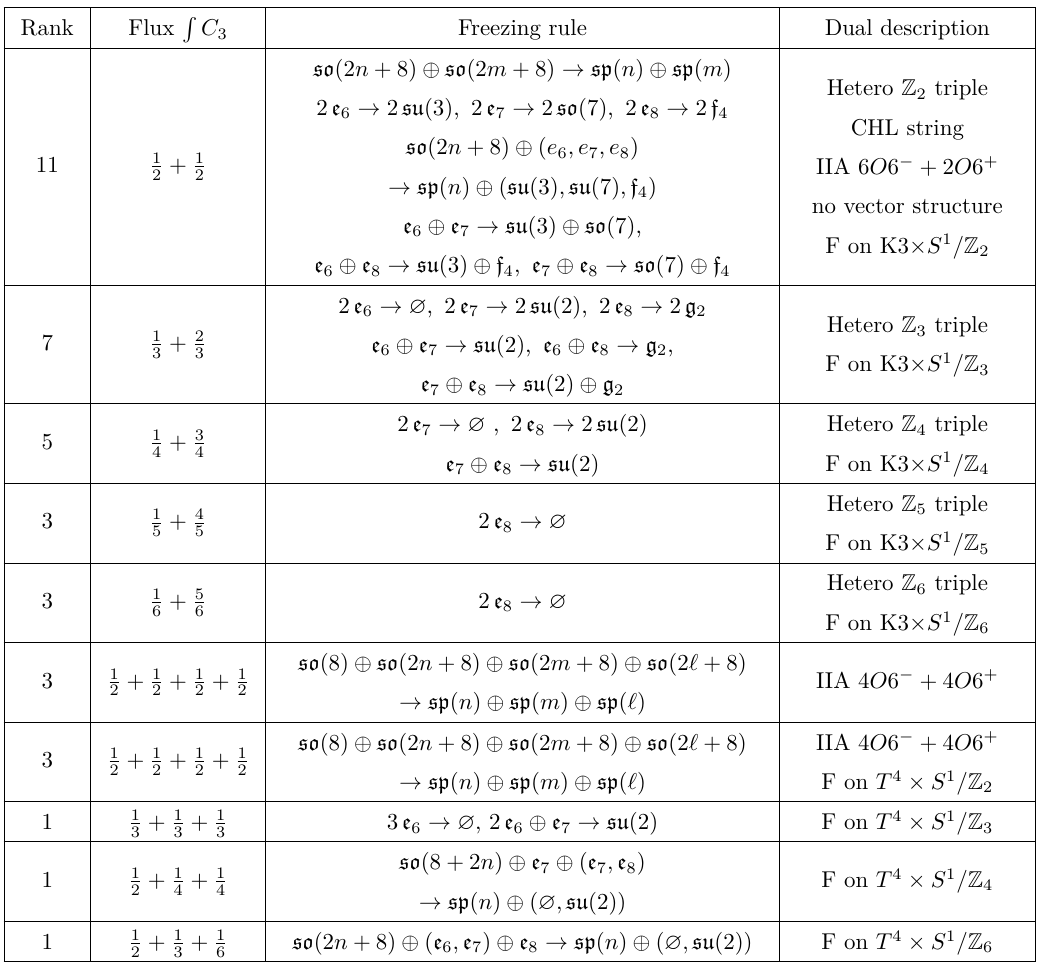
Table 6 . List of 7d theories with reduced rank [9, 51, 68]. The reduced rank theories are obtained by putting the flux in table 5, where the total flux must vanish mod 1 in the compact manifold.